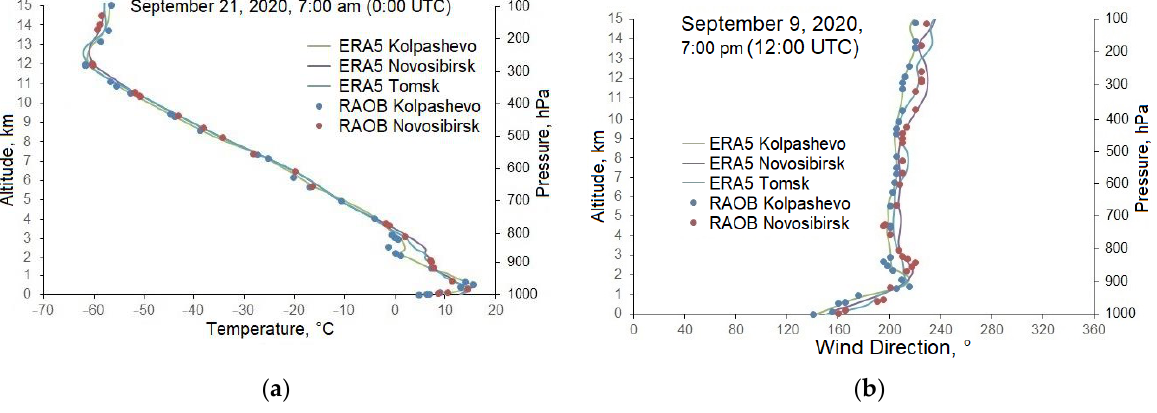
Figure 4. Vertical profiles of temperature ( a ) and wind direction ( b ) from data of the radiosonde observations (RAOB) and reanalysis (ERA5) for the Kolpashevo, Novosibirsk and Tomsk coordinates.